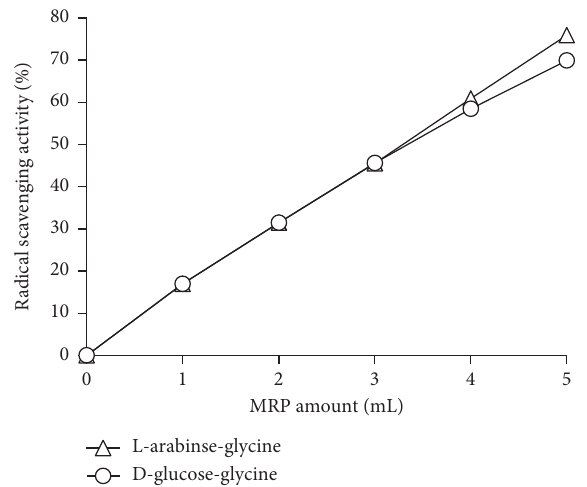
Figure 3: DPPH radical-scavenging activity of the Maillard re- action product (MRP) of an L-arabinose/glycine